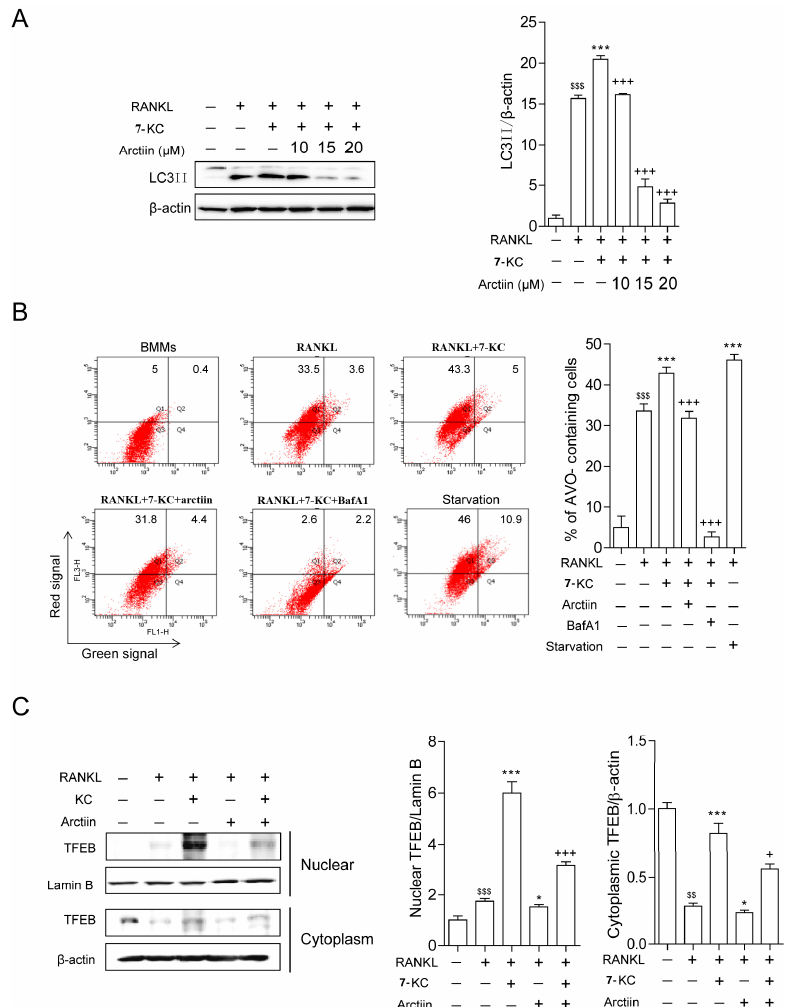
Figure 3. Arctiin decreases autophagy by disrupting 7-KC-stimulated TFEB nuclear localization. ( A ) BMMs were incubated with M-CSF (30 ng/mL) and RANKL (40 ng/mL) in the presence or